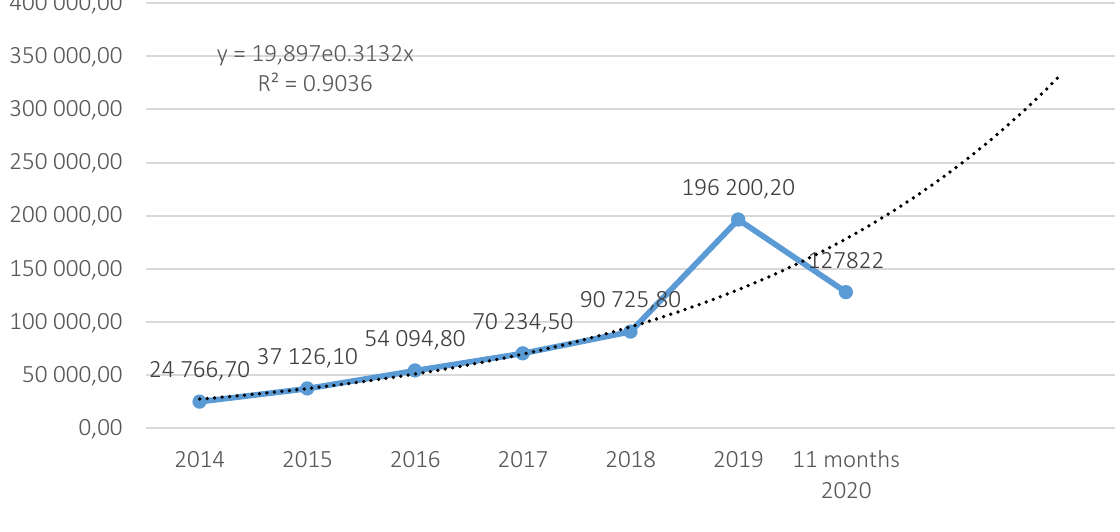
The amount of tourist tax, UAH Figure 2. The trend line of the general tourist tax dynamics of Ukraine’s regions in 2014–2019 and for 11 months of 2020 (exponential dependence)